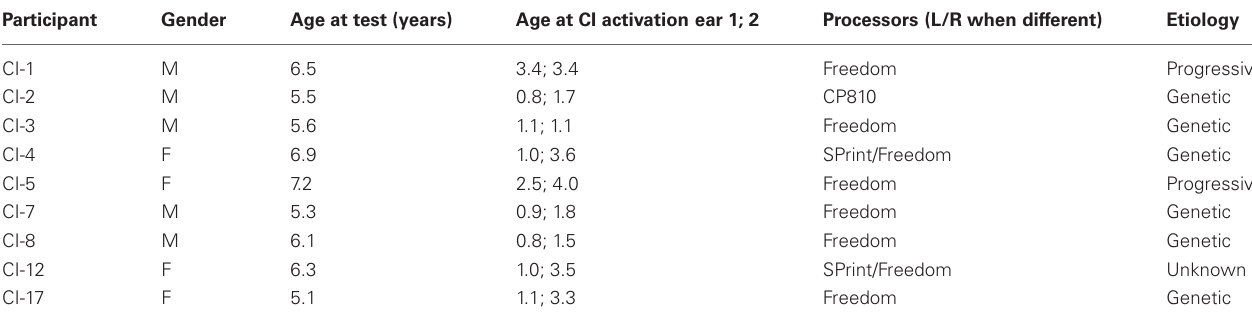
Table 1 | Description of the CI sample.